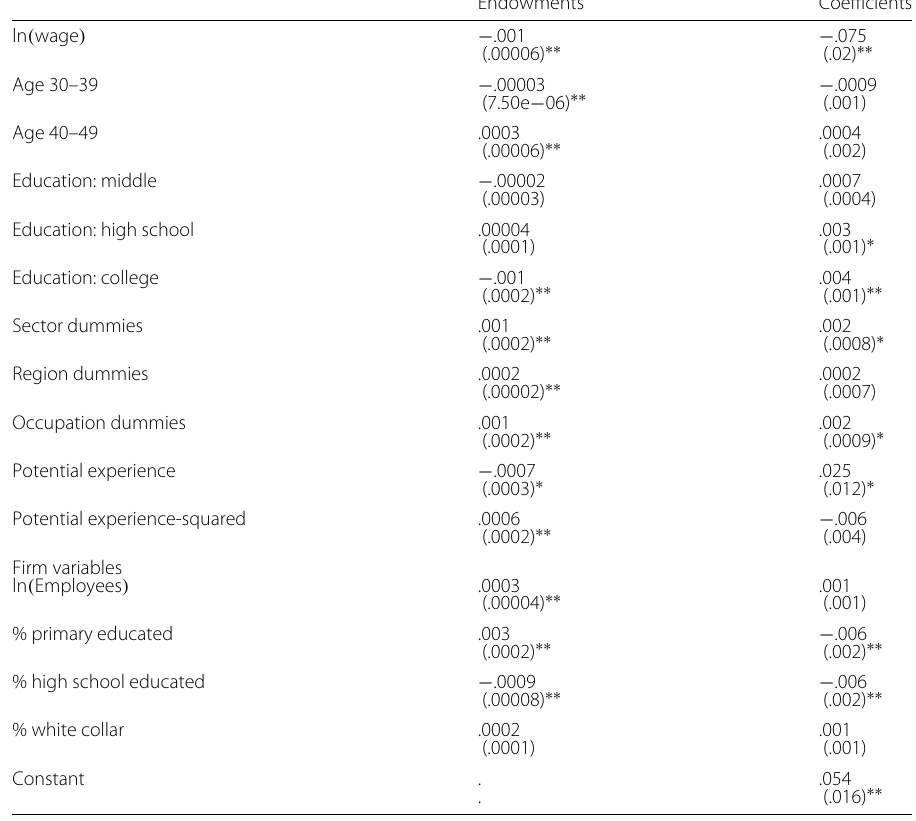
Table 6 Oaxaca decomposition of voluntary separation rates